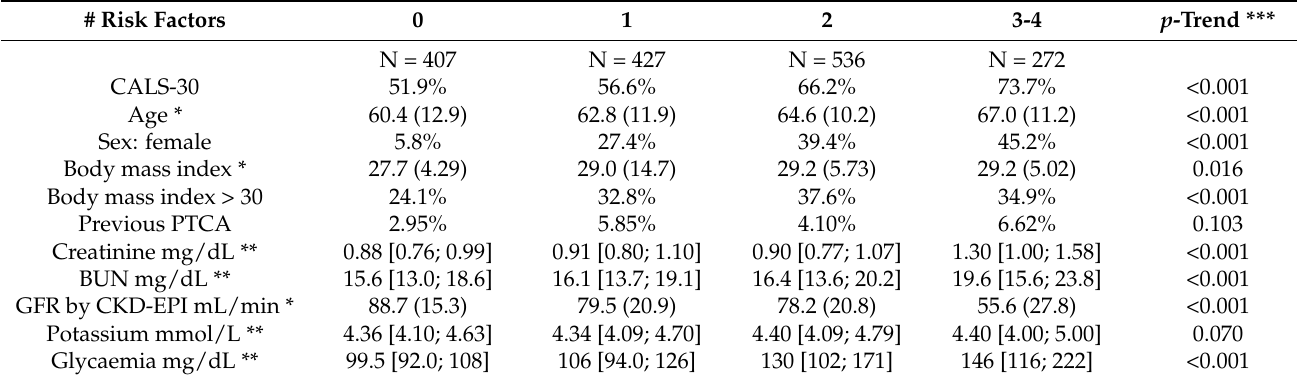
Table 4. Association of a score based on the number of accumulated classical risk factors (diabetes, hypertension, chronic kidney disease, and current smoking) with patient characteristics and the presence of coronary atherosclerotic lesions with ≥ 30% stenosis (CALS-30).